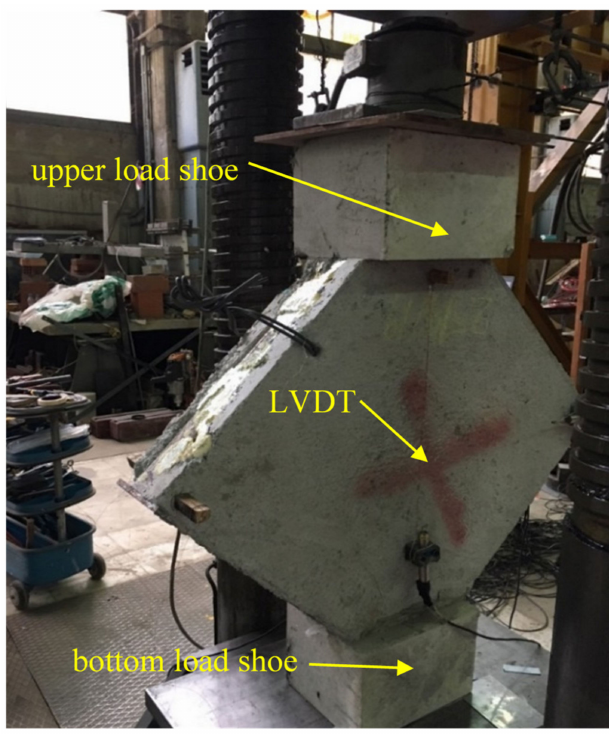
Figure 9. Experimental setup of PCSP-3a subjected to diagonal compression